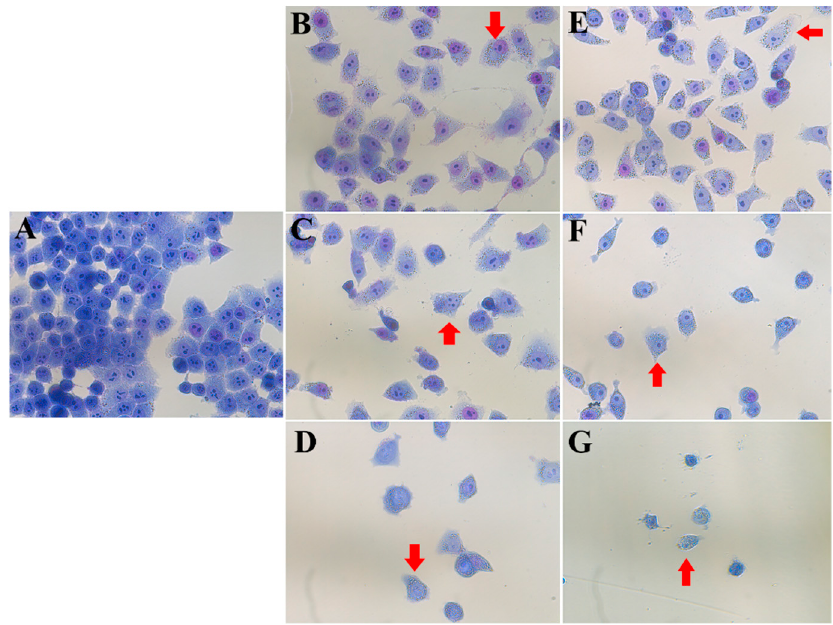
Figure 3. Morphological structure of HeLa cancer cells through Giemsa staining after 48 h of treatment with different concentration of compounds 3 or 4 . ( A ) control (untreated), ( B ) compound 3 (15 μ M), ( C ) compound 3 (20 μ M), ( D ) compound 3 (25 μ M), ( E ) compound 4 (10 μ M), ( F ) compound 4 (15 μ M), and ( G ) compound 4 (20 μ M). The arrows show the obviously changed cells.